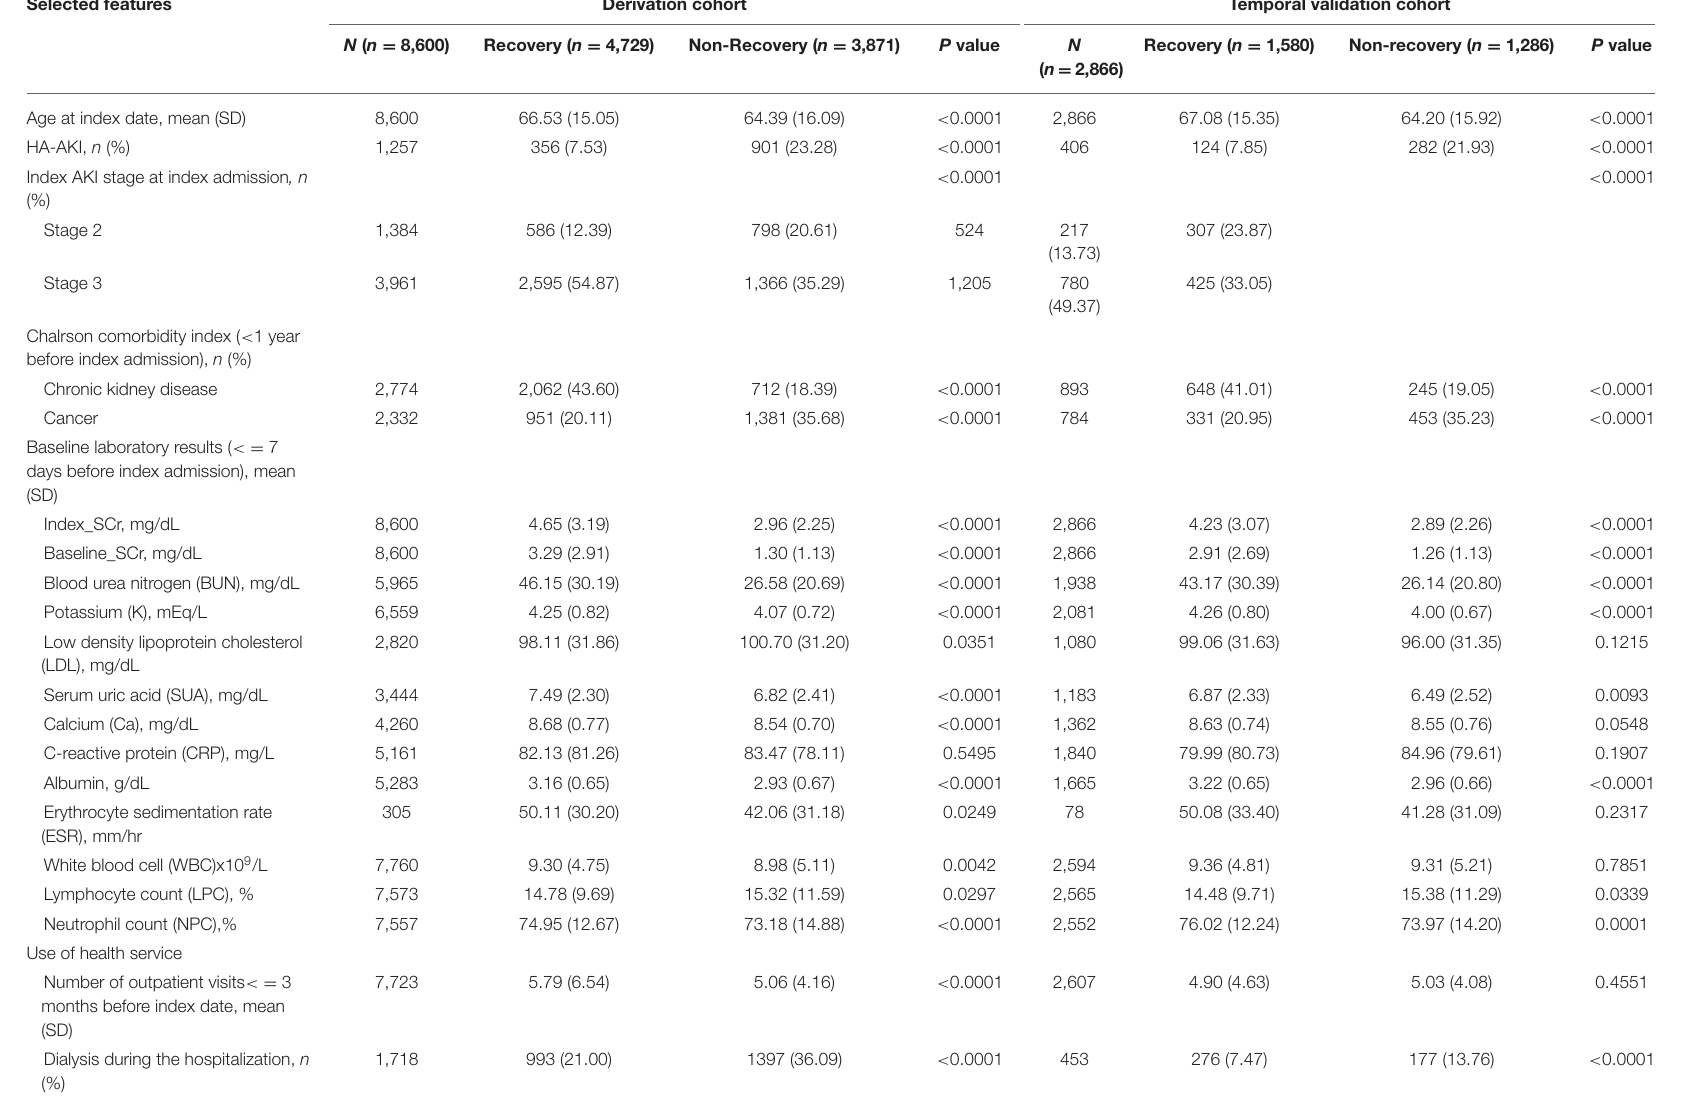
TABLE 1 | Top 20 important features for predicting acute kidney injury (AKI)